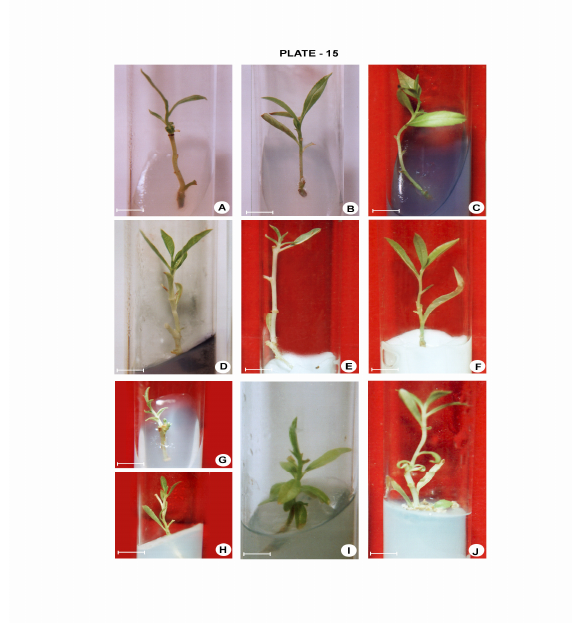
Fig. 3.Control of In vitro shoot tip necrosis (STN) in